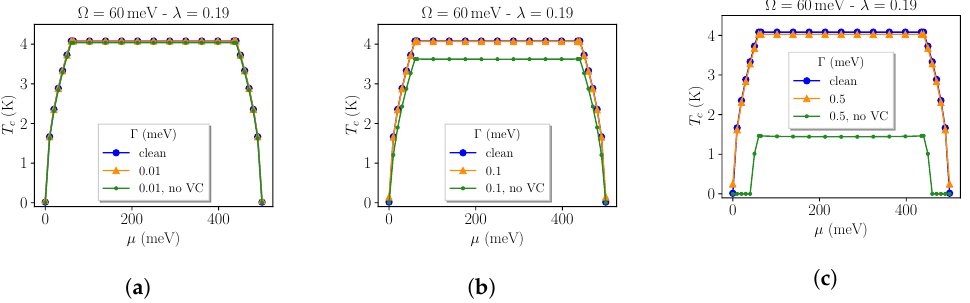
Figure 3. Critical temperatures for the single finite band ( w = 0, Λ = 500 meV, Ω = 60 meV, λ = 0.19) calculated for the single finite band with different disorder-induced broadening ( a ) Γ = 0.01 meV, ( b ) Γ = 0.1 meV and ( c ) Γ = 0.5 meV. The blue dots one can see the clean system ( Γ = 0), the dirty cases are plotted in orange, while in green, one can see the calculation where the vertex correction is suppressed by